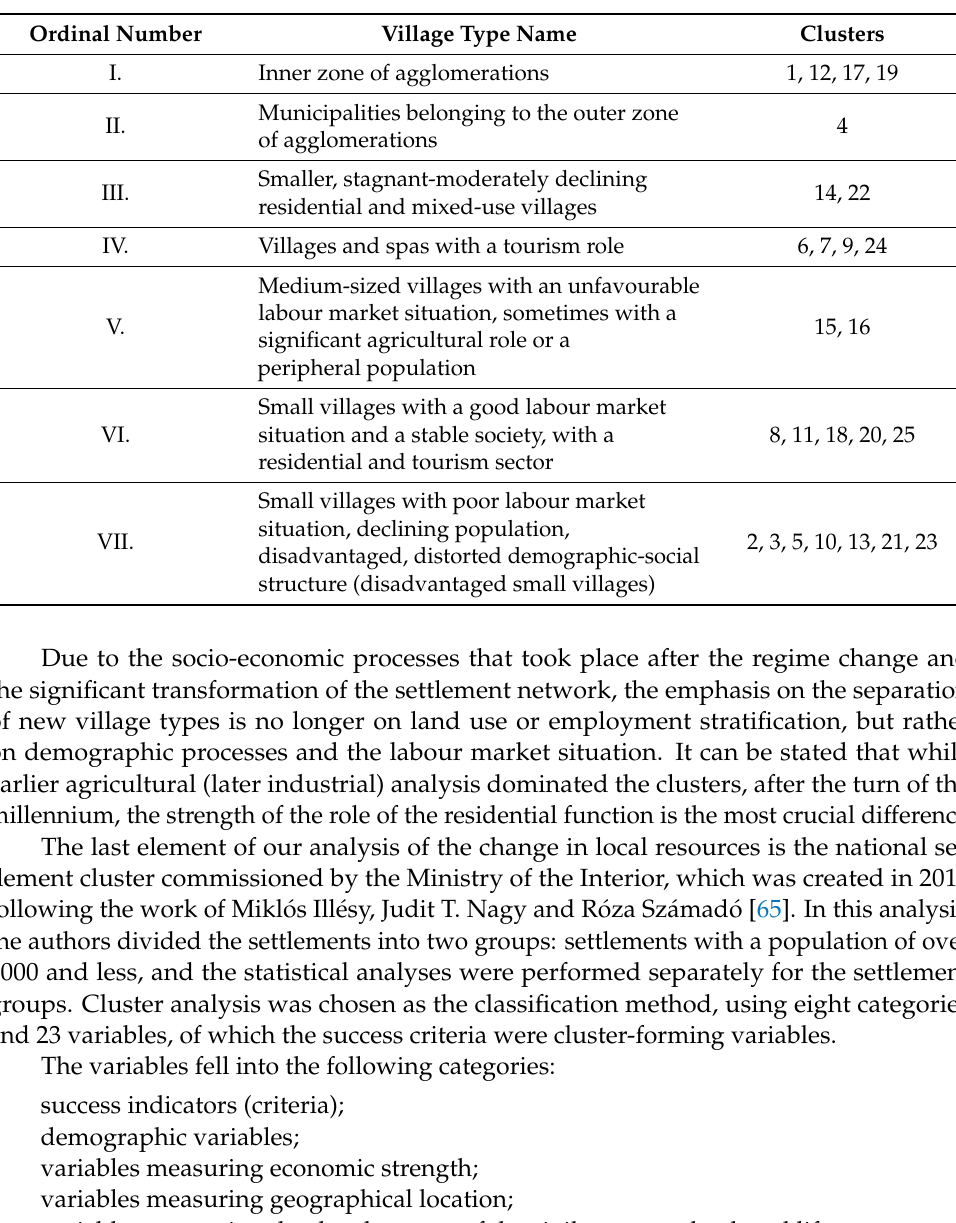
Table 2. The name of the village types in Hungary, 2007